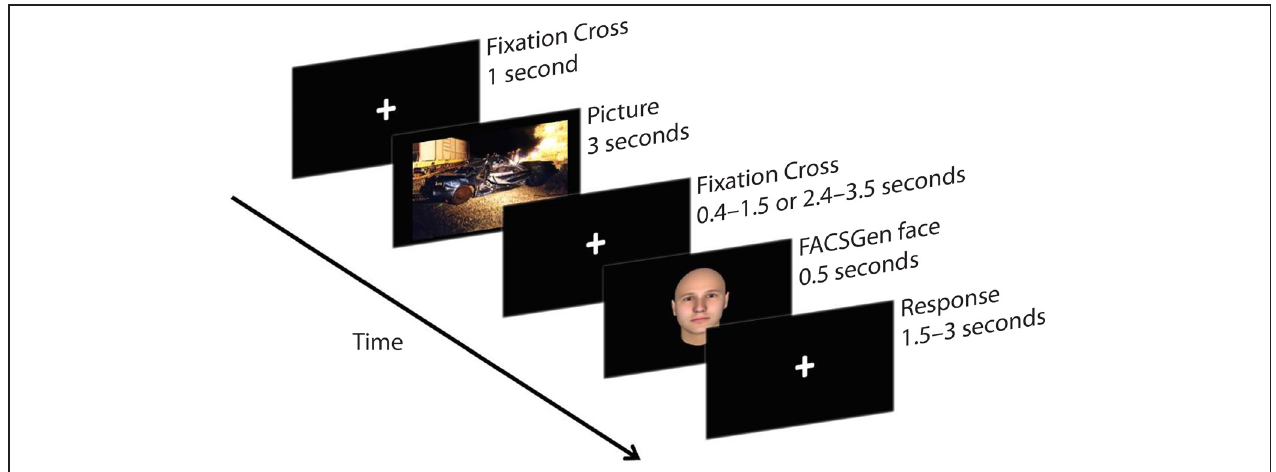
FIGURE 1 | A sample trial from the emotional recovery task: a fixation cross was presented at the center of the screen to direct participants’ attention. Next, an IAPS image was presented, followed by a variable